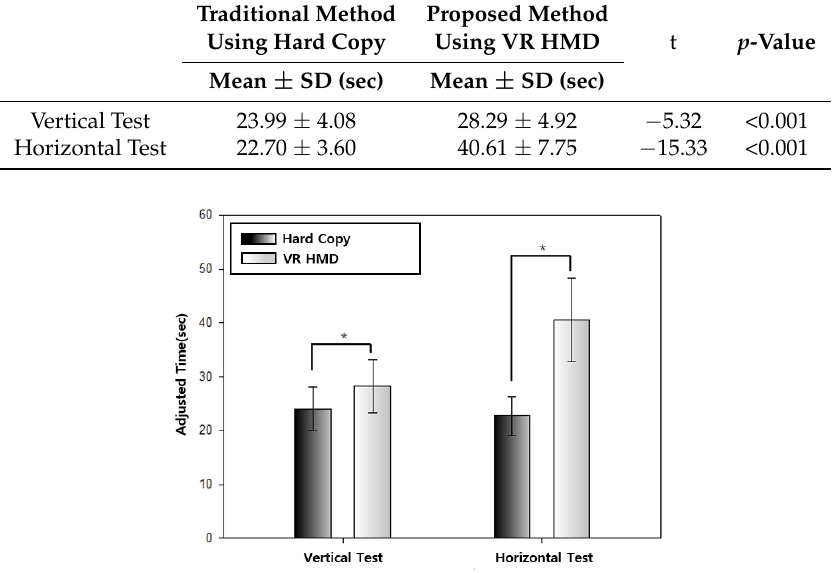
Figure 6. A chart comparison of the adjusted